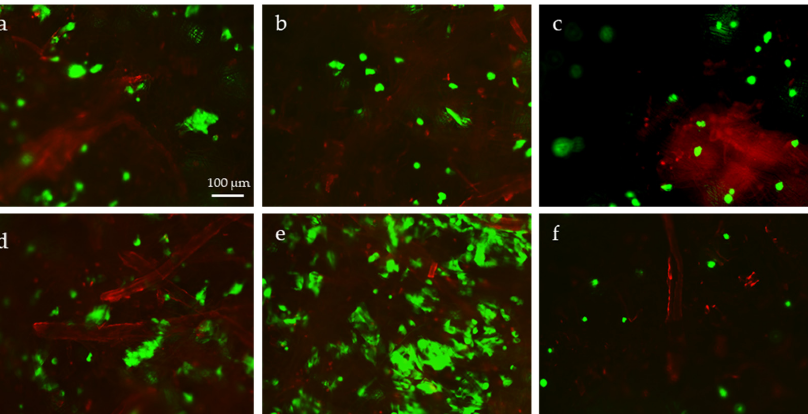
Figure 5. Direct cytotoxicity test: Live/Dead viability test performed on HaCaT cell line seeded on cellulose tissues electrosprayed with: ( a ) sCNs (water); ( b ) sCNs (water/acetic acid); ( c ) sCNs (water/HFlP); ( d ) mCNs (water); ( e ) mCNs (water/acetic acid). ( f ) Pristine cellulose tissue. Viable cells are stained in green, dead cells are stained in red, and the cellulosic tissue shows autofluorescence mainly in the red channel.